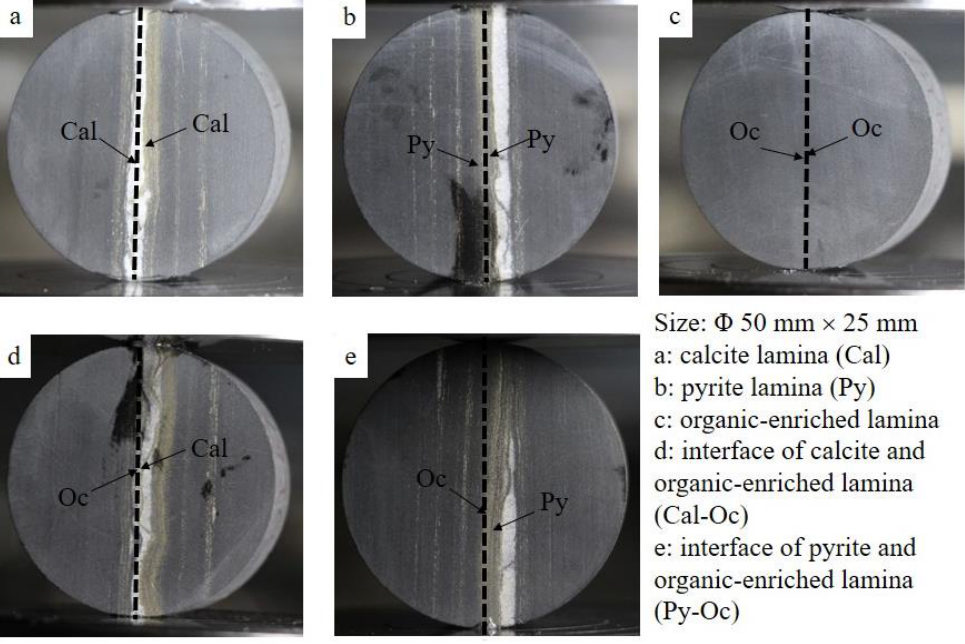
Figure 2. Brazilian discs prepared with various laminae.